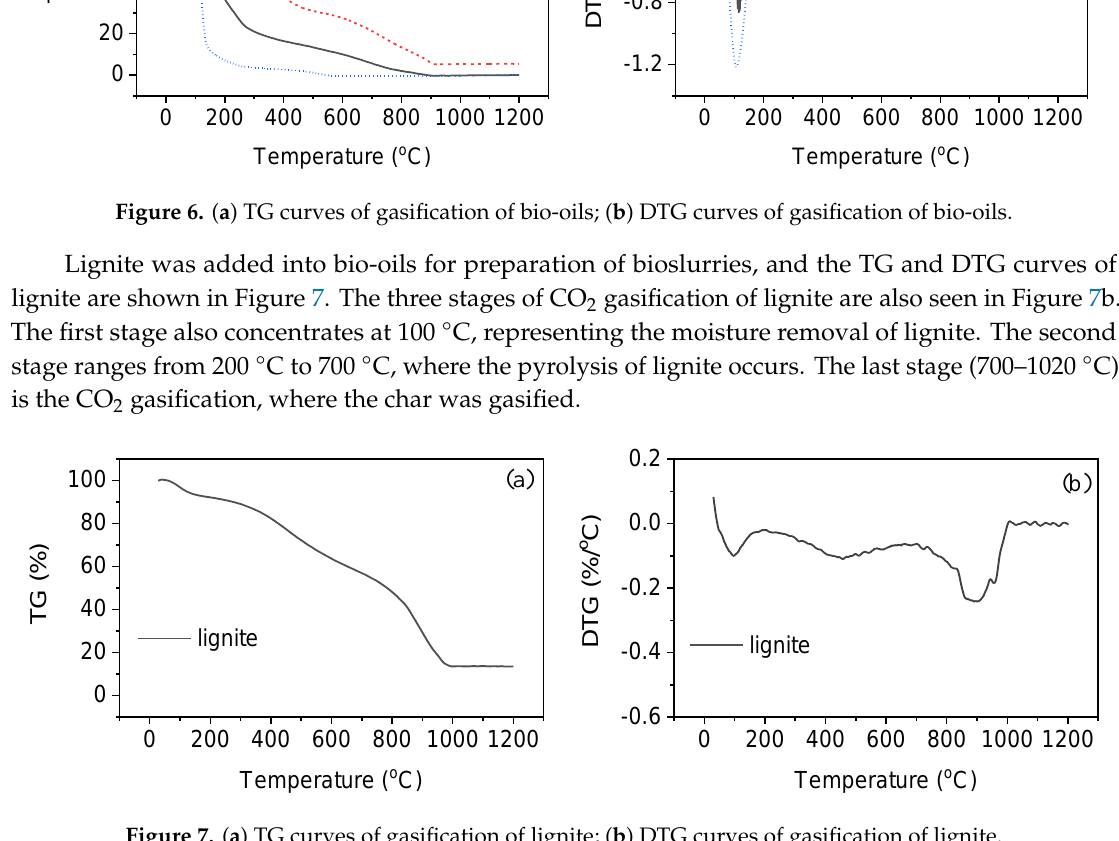
Table 3. Gasification performance indices of individual fuels.